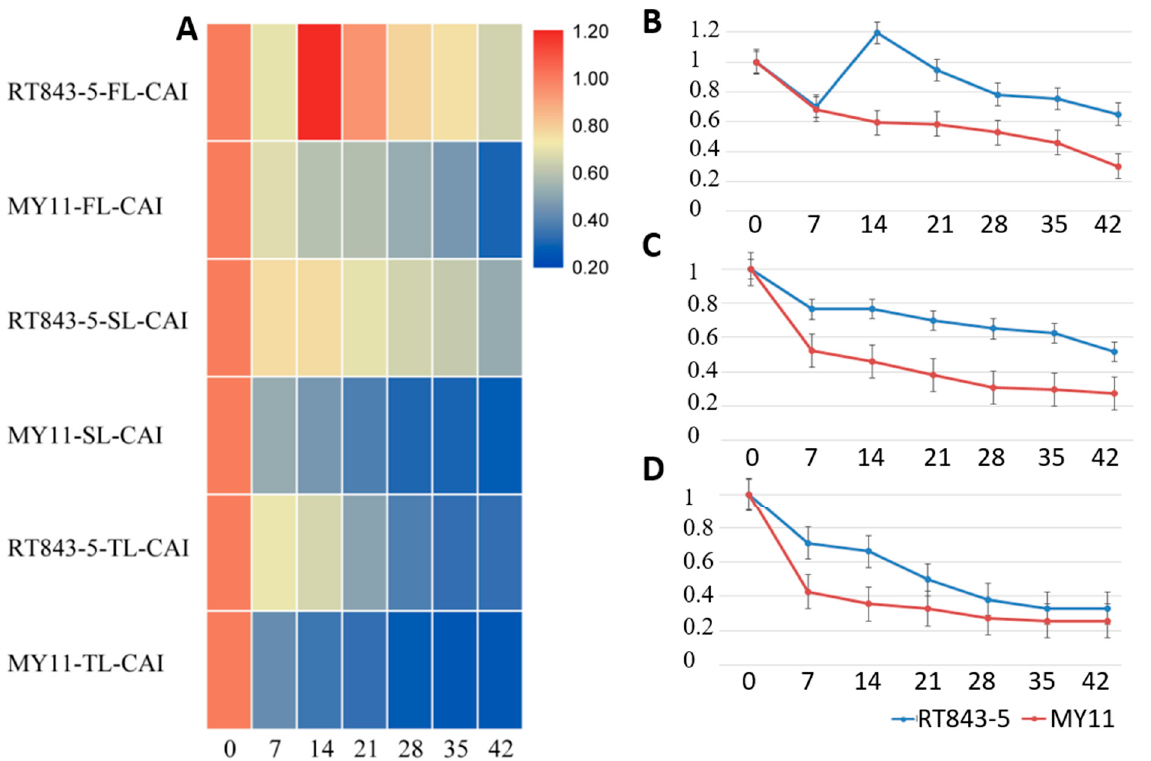
Figure 7. Differences in the CAI (CAT activity index) between RT843-5 and MY11 during leaf senescence after anthesis. ( A ): Heatmap of the changes in the CAI in the FL, SL, and TL. The different colors show the different values of the CAI. ( B ): The change curve of the CAI of the FL; ( C ): The change curve of the CAI of the SL; ( D ): The change curve of the CAI of the TL. The Y-axis shows the CAI values, and the numbers on the X-axis show the days after anthesis.